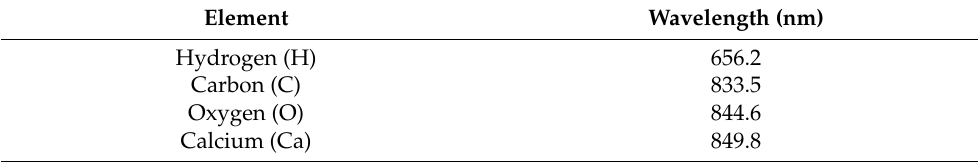
Table 3. Selected emission